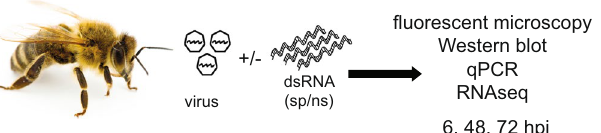
Figure 1. Schematic of honey bee virus infection trials. Schematic representation of the experiments performed to investigate honey bee antiviral immune mechanisms, including dsRNA triggered immune responses. Honey bees were infected with virus, SINV-GFP, and/or treated with dsRNA, which was composed of either virus- specific dsRNA (sp-dsRNA) or nonspecific dsRNA (ns-dsRNA). Bees were collected at 6, 48, and 72 hours post infection (hpi); virus abundance in individual bees was assessed by fluorescence microscopy, Western blot analysis, and qPCR. Honey bee gene expression was assessed using RNASeq. Honey bee image courtesy of Kathy Keatley Garvey; used with